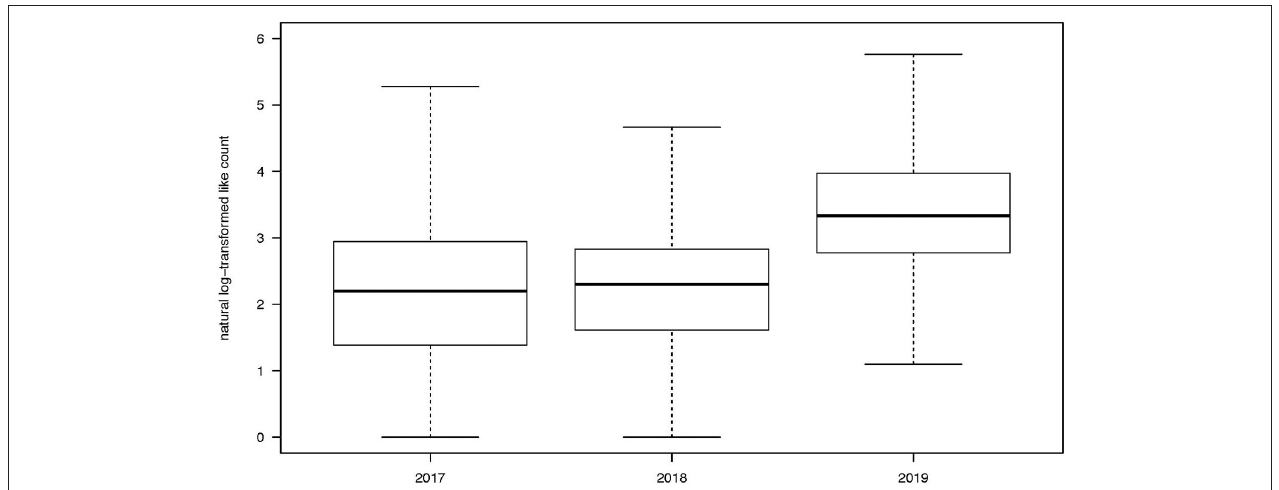
FIGURE 2 | Median like count for vaping-related Instagram posts collected during the 2017 sampling period ( N = 22,293), during the 2018 sampling period ( N = 21,906), and the June 2019 sampling period ( N = 22,000). The lower whiskers are shown as the 25th percentile − 1.5*IQR; the upper whiskers are shown as the 75th percentile +